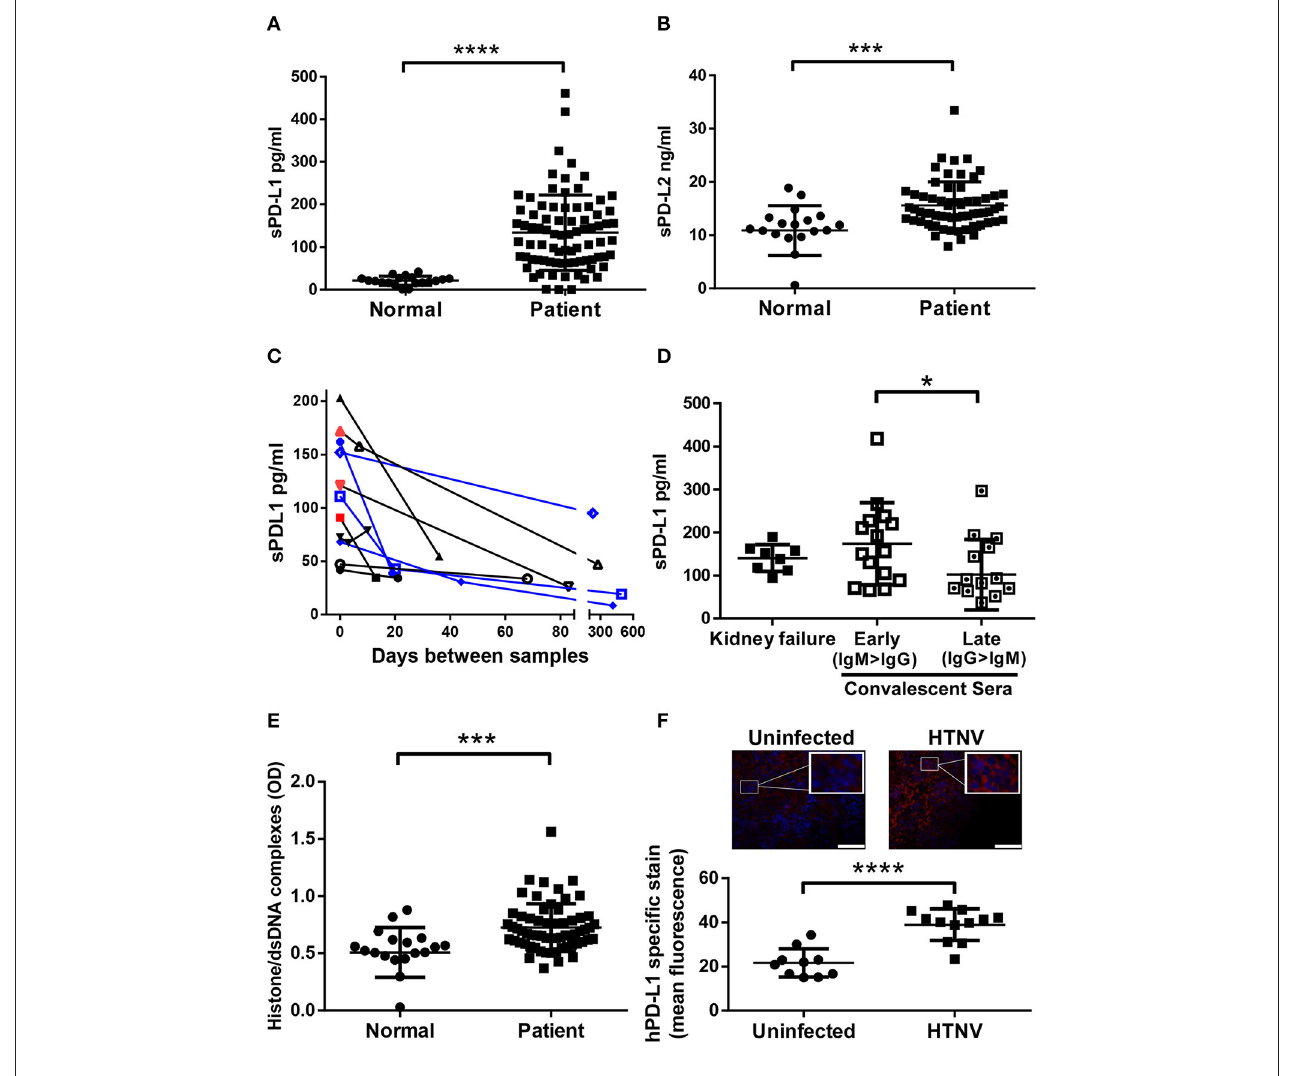
FIGURE 1 | Levels of sPD-L1, sPD-L2, hantavirus-specific IgG and NETs in sera from hantavirus-infected patients. Sera from normal healthy individuals or convalescent hantavirus-infected patients (after the viremic phase) was tested by ELISA for levels of (A) sPD-L1 and (B) sPD-L2. Error bars represent the mean ± SD (**** p < 0.0001, *** p < 0.001, paired Student’s t-test). (C) Sequential sera samples from patients with PUUV (black) or DOBV (blue) were tested for sPD-L1. Red samples also tested additionally positive for hantavirus RNA and are therefore acute infections. (D) Levels of sPD-L1 in patients with kidney failure or in convalescence were further analyzed. Convalescent sera were separated into early convalescent (IgM dominant) or late convalescent (IgG dominant). Error bars represent the mean ± SD (* p < 0.05, paired Student’s t-test). (E) The level of NETs in sera from normal healthy individuals or convalescent hantavirus-infected patients was determined as previously described (27). Error bars represent the mean ± SD (*** p < 0.001, paired Student’s t-test). (F) Spleen sections from uninfected or HTNV-infected humanized mice were stained for human PD-L1 (red) and nuclei (blue). HTNV-infected spleen sections show large areas of human cells with enhanced PD-L1 expression in comparison to uninfected spleen sections (upper left and right panel; inserts show higher magnification of cells; bars represent 100 µ m). Slides from uninfected and HTNV-infected humanized and unreconstituted mice animals (N = 3 each group; 12 total) were analyzed using ImageJ to determine the intensity of human PD-L1 staining (Lower panel). Error bars represent the mean ± SEM (**** p < 0.0001, paired Student’s t-test). The samples from unreconstituted mice were used to determine the background staining. No significant difference was found in background staining in HTNV-infected or uninfected unreconstituted